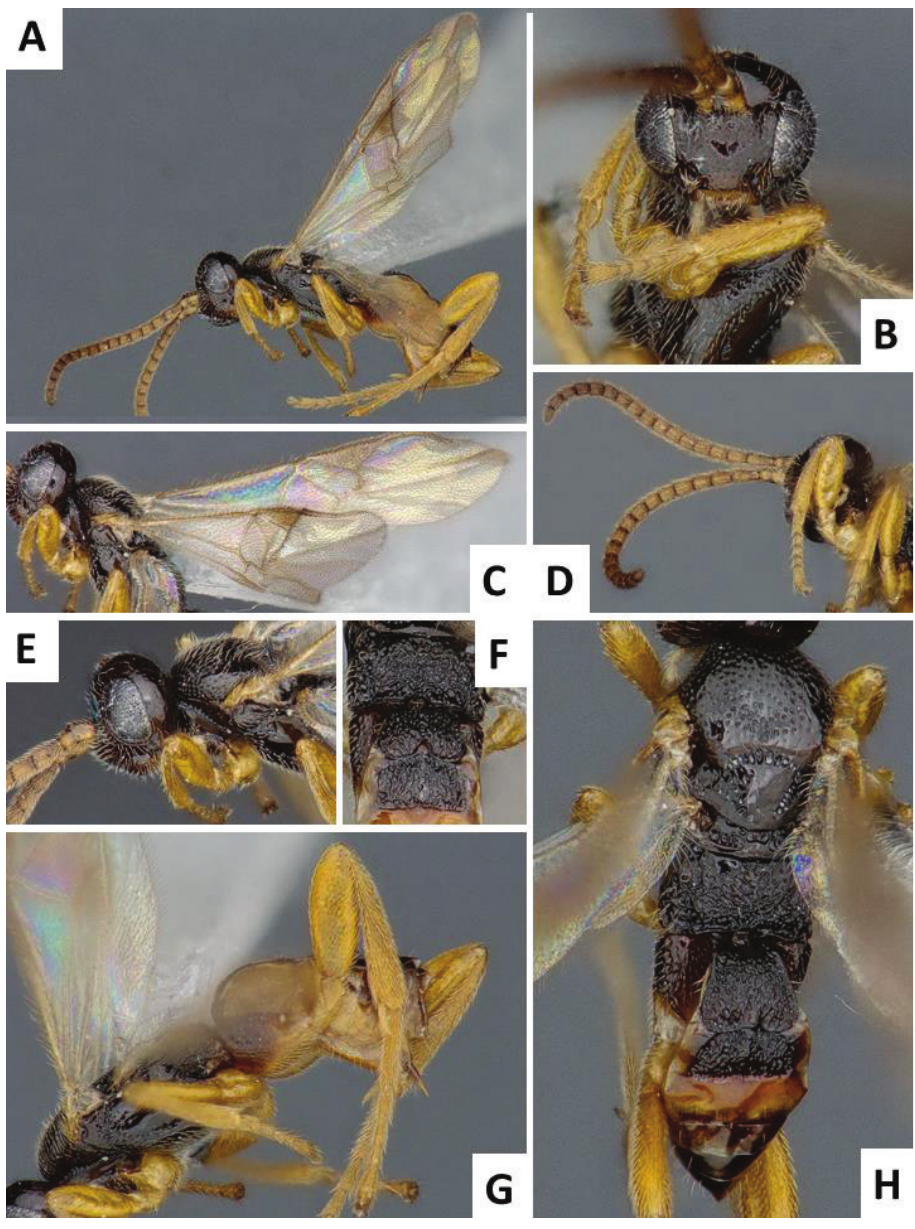
Figure 8. Cotesia chilonis , female specimen from Takatsuki, Japan. A Habitus, lateral view B Head, fron- tal view C Wings D Antennae, front and middle legs, lateral view E Head, lateral view F Propodeum, ter- gites 1-2, dorsal view G Mesosoma and metasoma, lateral view H Mesosoma and metasoma, dorsal